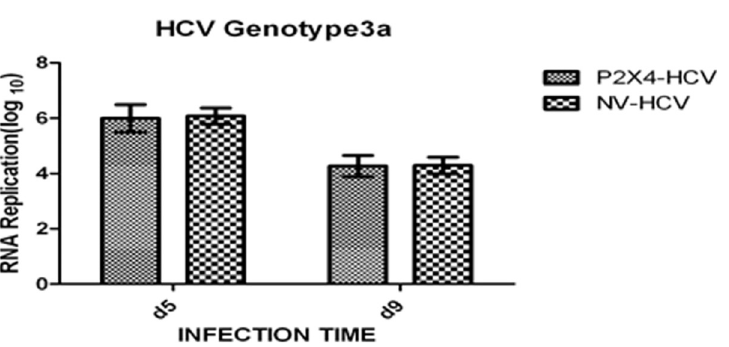
Fig 10. HCV RNA was quantified by RT-QPCR after infection in stable cell lines. All values are expressed as mean ± SEM � P � 0.05 vs. control NV/HCV.